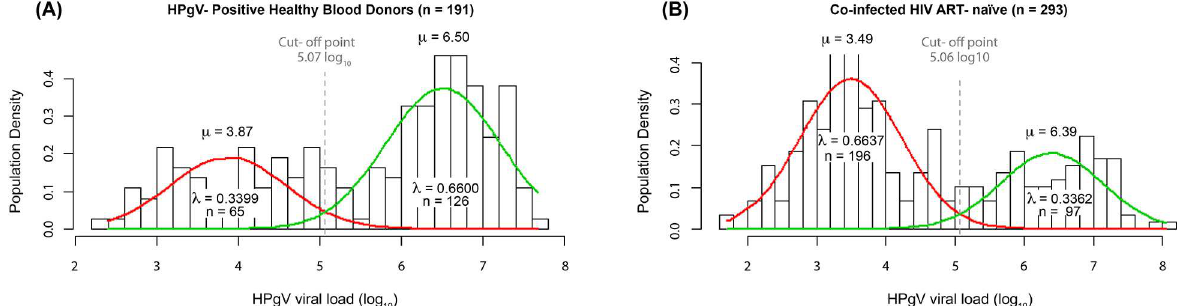
Fig 2. Two-component cluster mixture model fit for weighted HPgV viral load from healthy blood donors and co-infected ART- na ï vepatients. Density distribution(bars) of HPgV viral load (log 10 genomeequivalents) from healthyblood donors (A) and co-infected ART-na ï ve patients (B). Gaussiancurves indicate the fitted low (red line), high (green line), mean componentcurves ( μ ), the numberof patients (n) and proportion( λ ) in each populationcomponent.The clusters’ cut-off point for healthy blood donors(A) and co-infected ART-na ï ve patients (B), is the intersectionof the